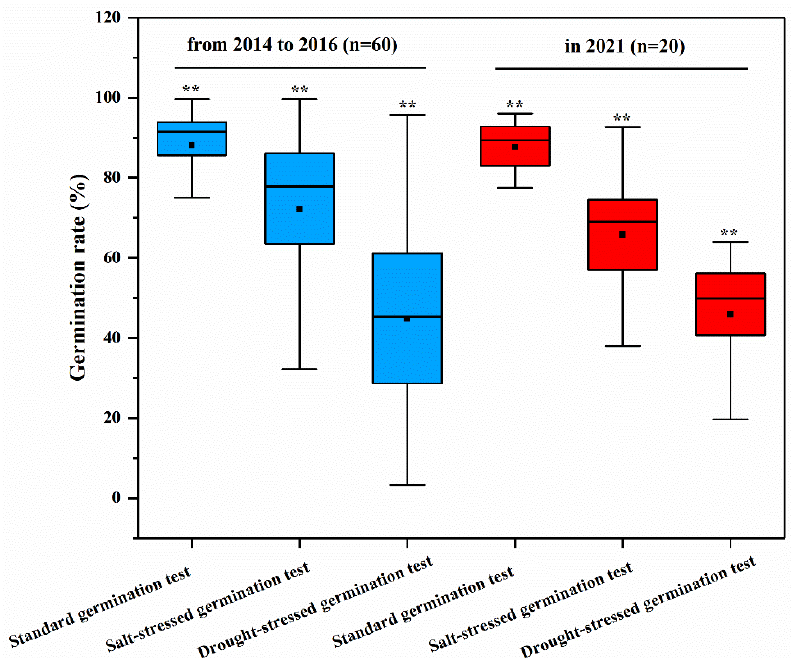
Figure 1. Seed vigor indicators of different rice cultivars. The box-whisker diagrams show the maximum (top of the vertical line), 75th percentile (top of the box), average (solid square within the box), 25th percentile (bottom of the box), median (horizontal line within the box), and minimum (bottom of the vertical line) values of the data. ** denotes significant differences in seed vigor indicators of different rice cultivars at the 0.01 probability level according to the Duncan’s test.